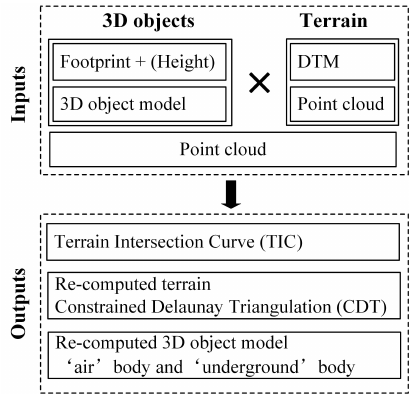
Figure 2. The inputs and outputs of this research. different inputs (Figure 2): (i) footprints (with information about building height) + DTM, (ii) footprints + Point cloud, (iii) 3D objects + DTM, (iv) 3D objects + 3D point clouds, and (v) Point cloud only.